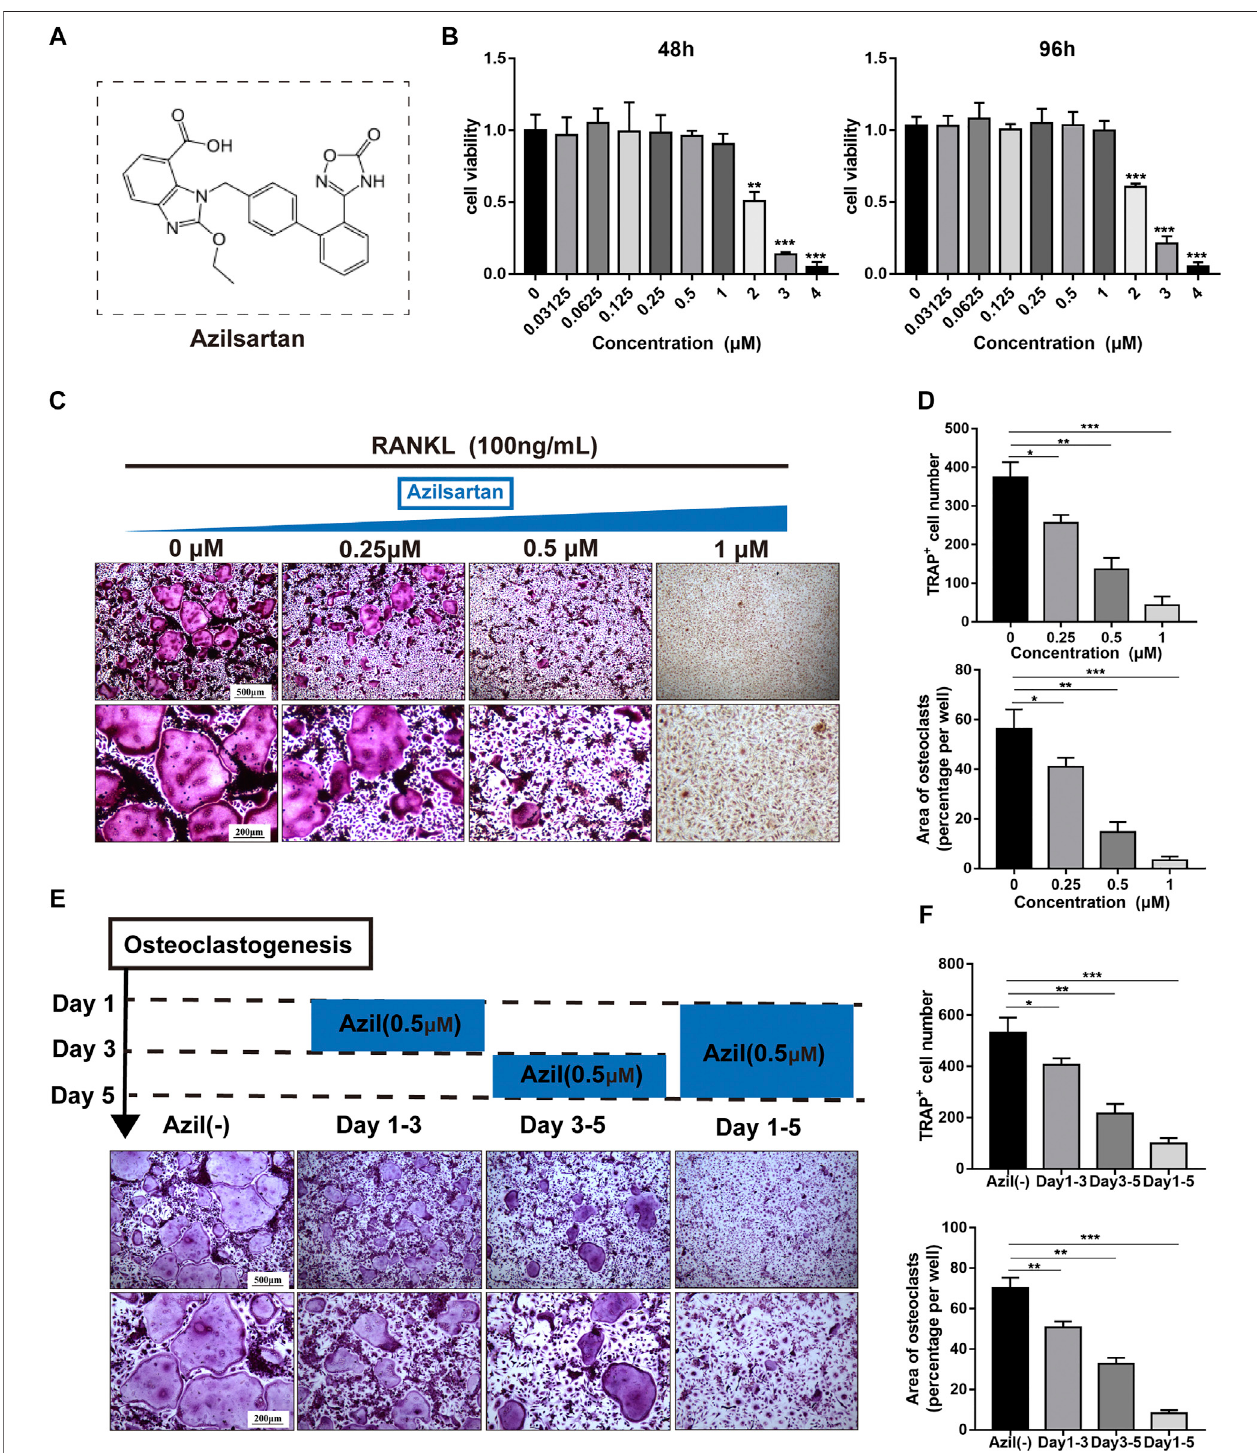
FIGURE 1 | Azilsartan inhibits RANKL-induced osteoclastogenesis in vitro . (A) The chemical structure of Azilsartan. (B) CCK-8 cytoxicity assay was performed to assess the cytotoxic effect of Azilsartan in BMMs at 48 h and 96 h. (C) BMMs were treated with M-CSF (25 ng/ml), RANKL (100 ng/ml) and various concentrations of Azilsartanfor5 days.Then thecellswere fi xedwith4%PFAandstainedforTRAP. (D) QuantitativeanalysisofTRAPpositivemultinucleatedcells(nuclei > 3)numberand the area per well (%) ( n (cid:2) 3). (E) TRAP staining images showing BMMs were treated with 0.5 μ M Azilsartan for indicated days during osteoclastogenesis. (F) Quantitative analysis of each group TRAP positive multinucleated cells in different time periods ( n (cid:2) 3). All data were obtained from three independent experiments and were shown as mean ± SD; (* p < 0.05, ** p < 0.01, *** p < 0.005, ns, no signi fi cance, compared with the untreated control group).